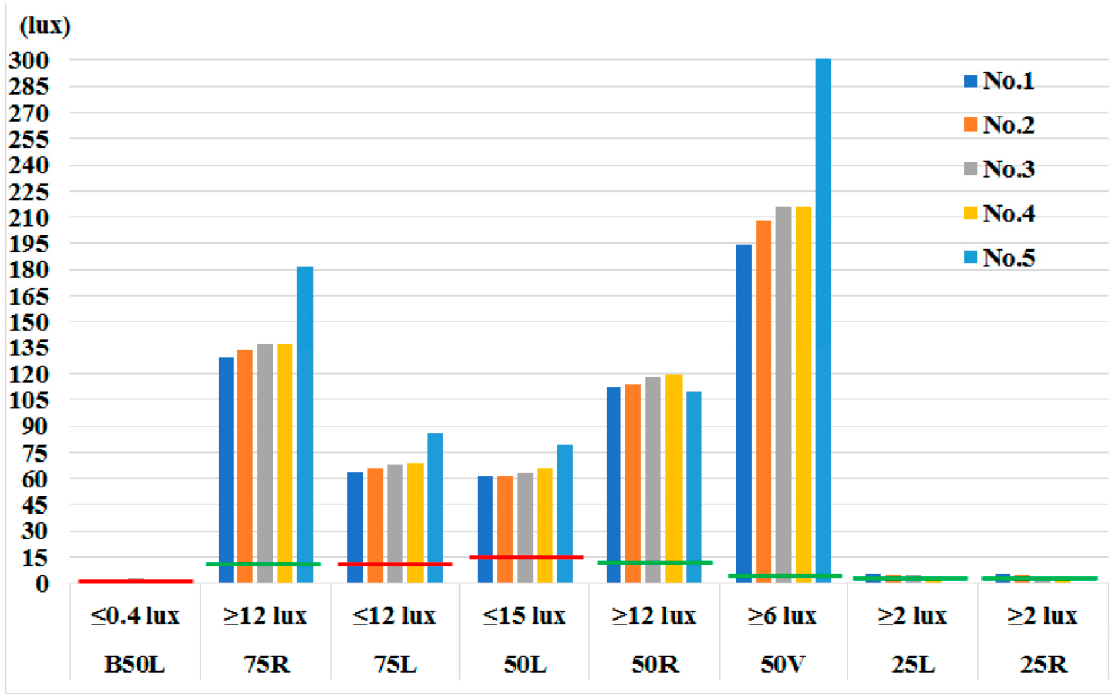
Figure 6. The simulated illuminances of the low-beam headlamps with primary ellipsoidal reflector Nos. 1 to 5 at the test points on the detection plane.